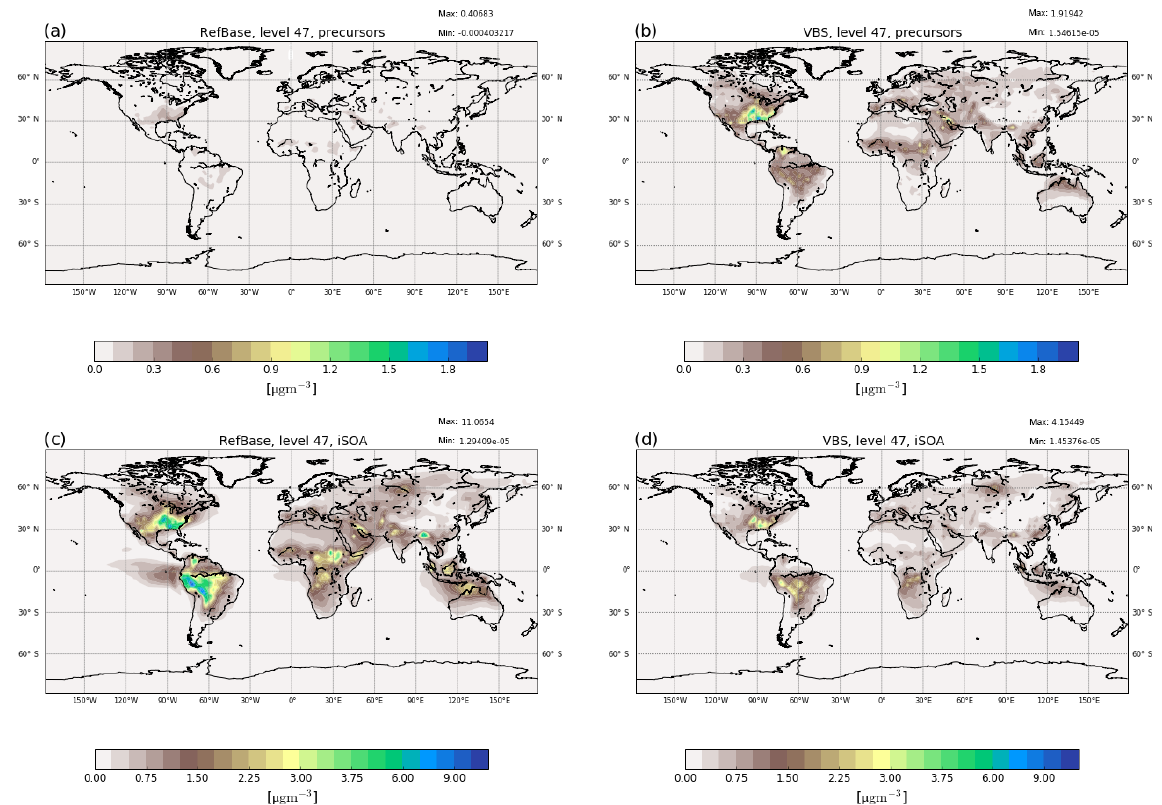
Figure 5. Surface average concentrations of gas-phase iSOA precursors (a, b) and aerosol-phase iSOA (c, d) for June, July and August 2012. Panels (a) and (c) show concentrations simulated by the reference run RefBase and panels (b) and (d) show the concentrations calculated by RefVBS using pseudo-chemistry and the VBS system. For RefBase the precursors consist of the four iSOA precursors (LNISOOH, LC578OOH, C59OOH, LISOPOOHOOH) described above; for RefVBS concentrations the sum of the gas-phase VBS classes VBSnonvol, VBS0 and VBS1 is